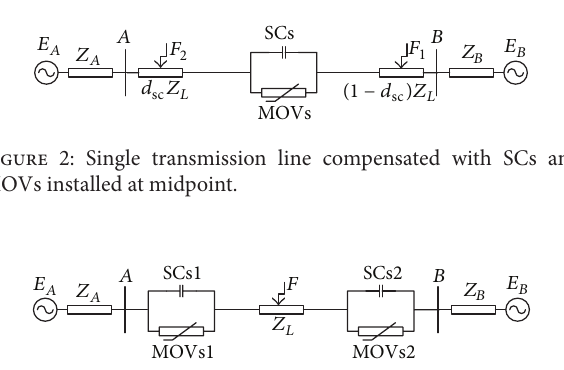
Figure 3: Transmission line compensated with SCs and MOVs installed at both